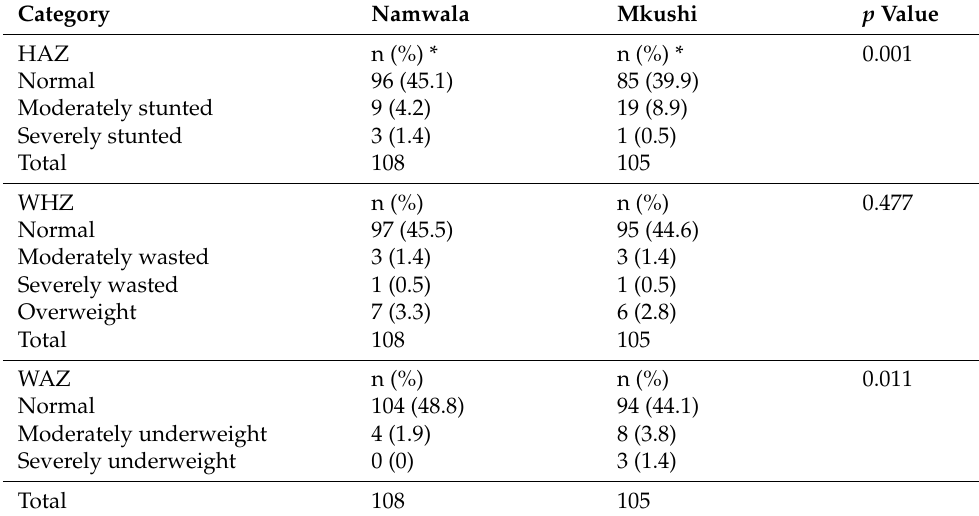
Table 3. Nutritional status of children aged 6–23 months in Namwala and Mkushi districts.